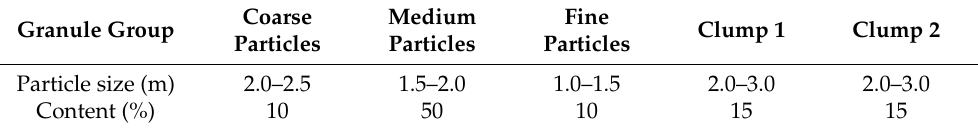
Table 1. PFC particle sizing.